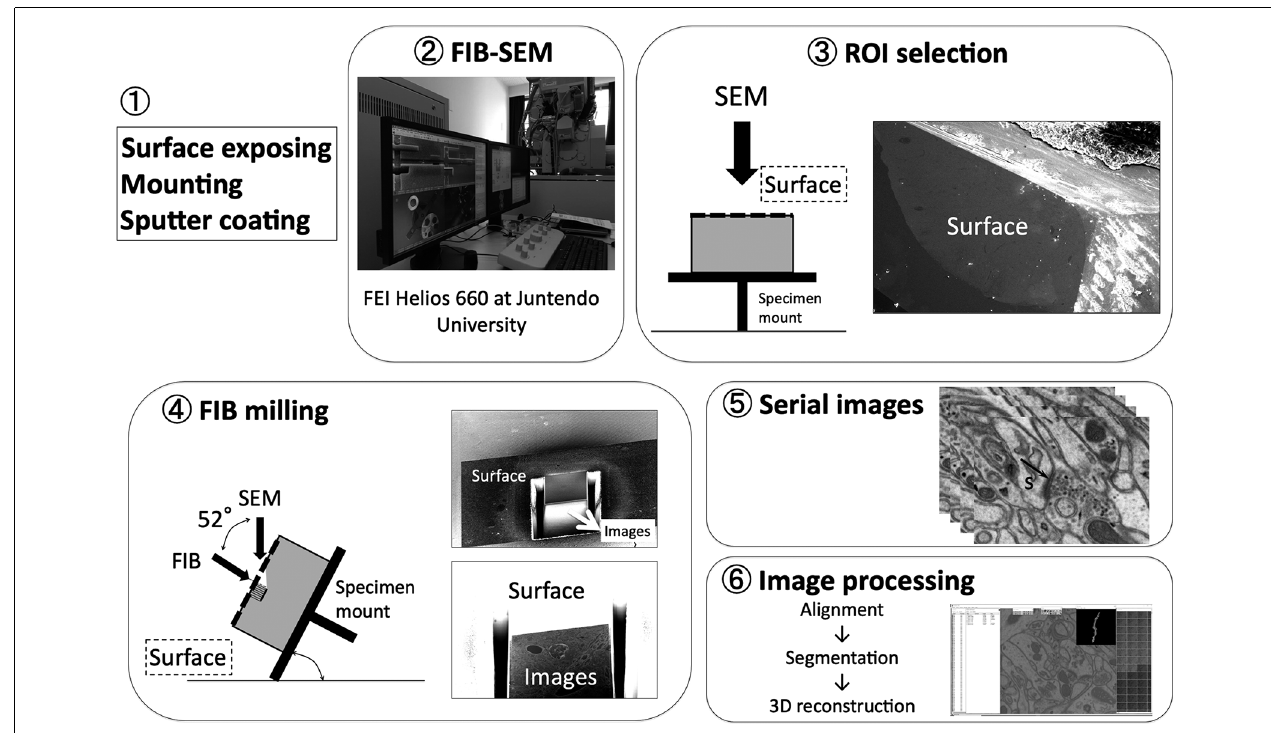
FIGURE 2 | Basic workflow of FIB-SEM. Modified from Koike (2018) with permission. A spine (s) can be clearly visualized with its postsynaptic density (PSD; indicated by black